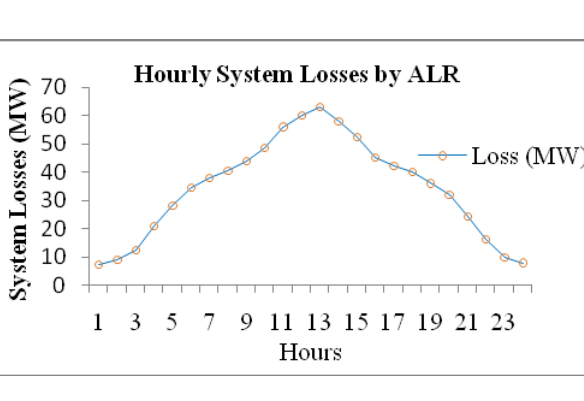
Figure 1. Hourly system loss